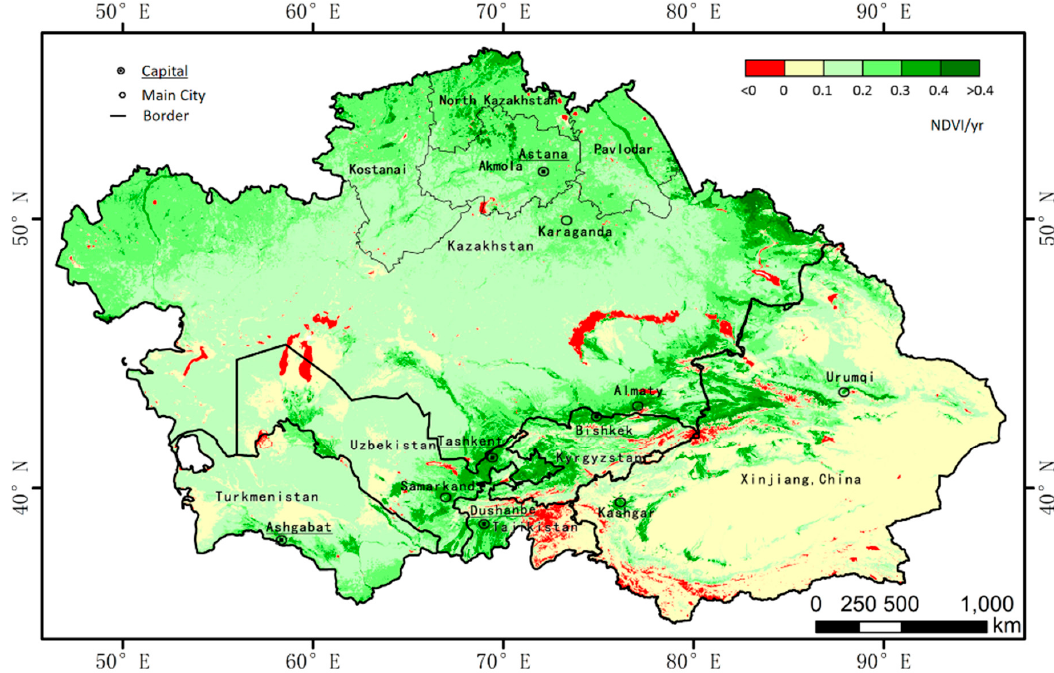
Figure 6. The NDVI trend in Central Asia from 2001 to 2017. NDVI/yr indicates the slope of the change in the annual average NDVI.